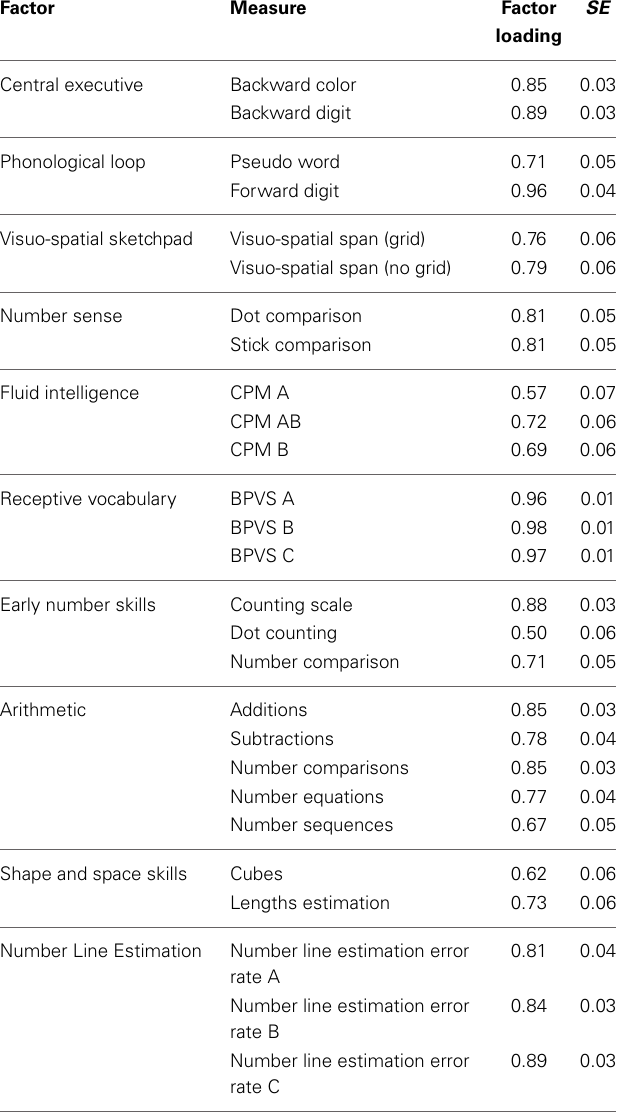
Table 3 | Standardized parameter